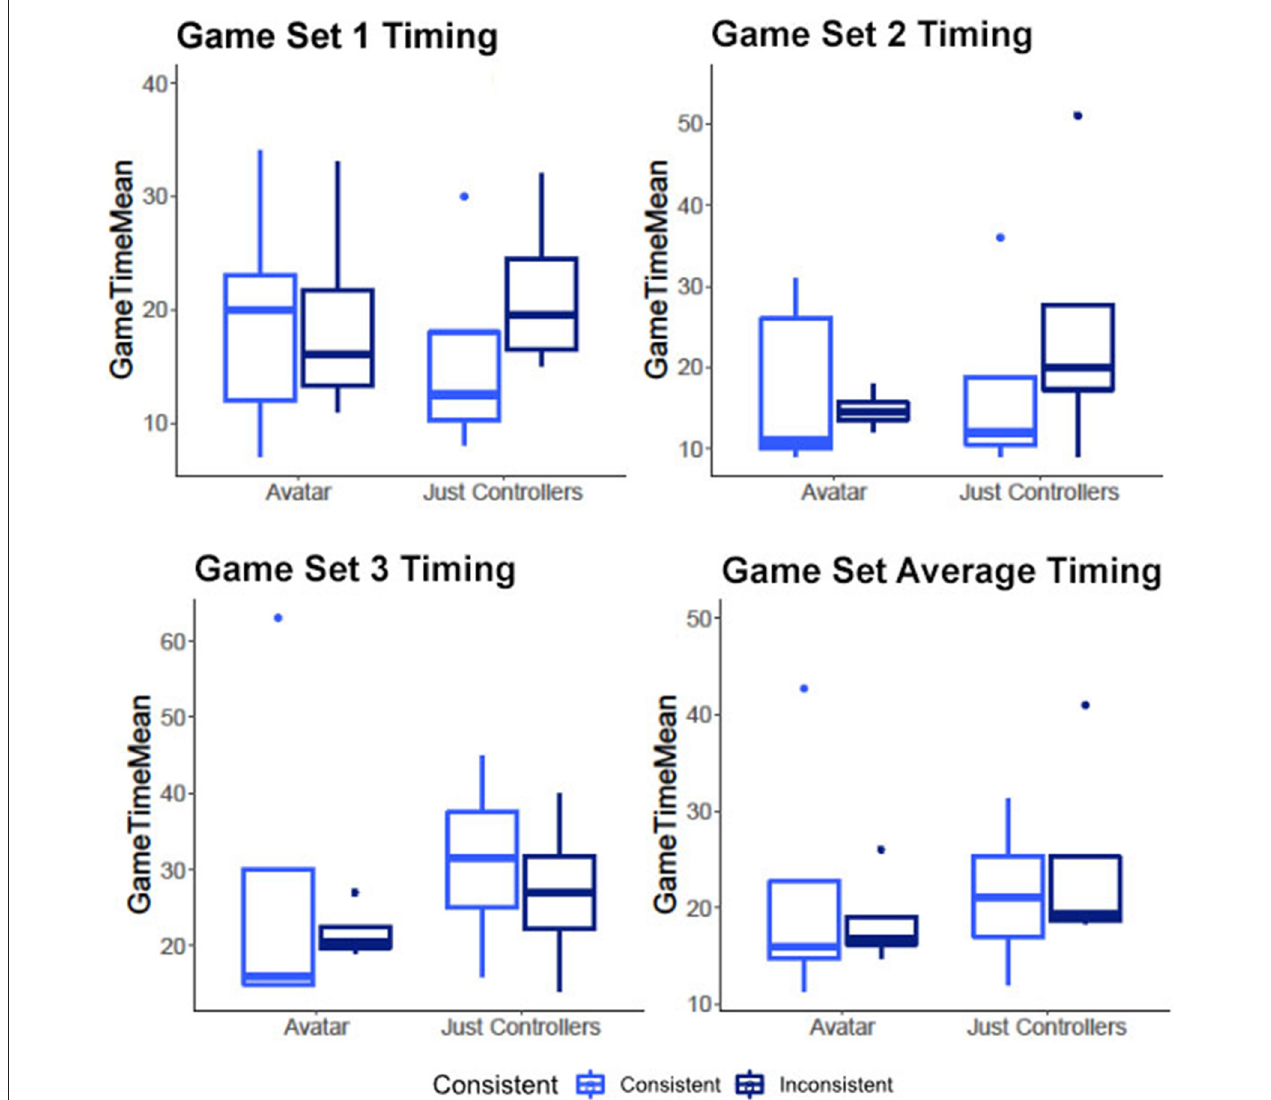
FIGURE 3 | Study 1: boxplots of “Build the Block” game set